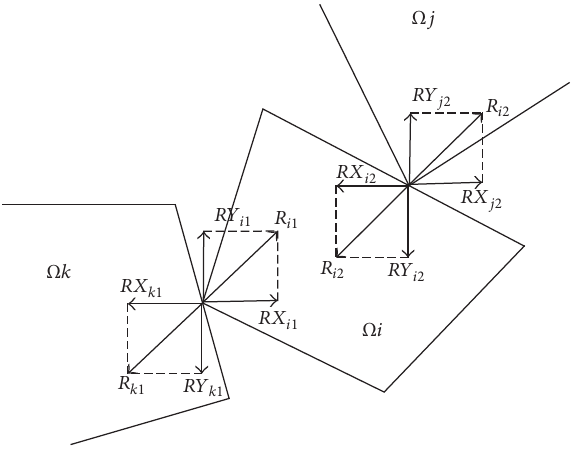
Figure 1: Contact model of